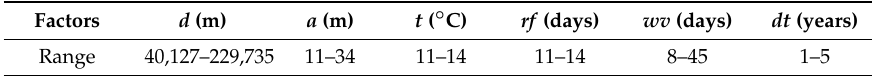
Figure 11. Effects of the influencing factors on ESDD and NSDD. ( a ) Distance from coastline; ( b ) Altitude; ( c ) Annual average temperature; ( d ) Medium to heavy rain. Table 4. The particle size distribution of the